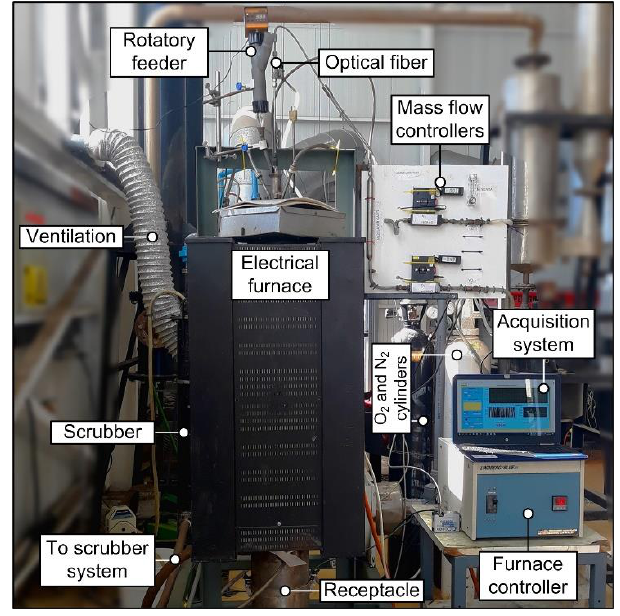
Figure 1. Experimental setup [6] .